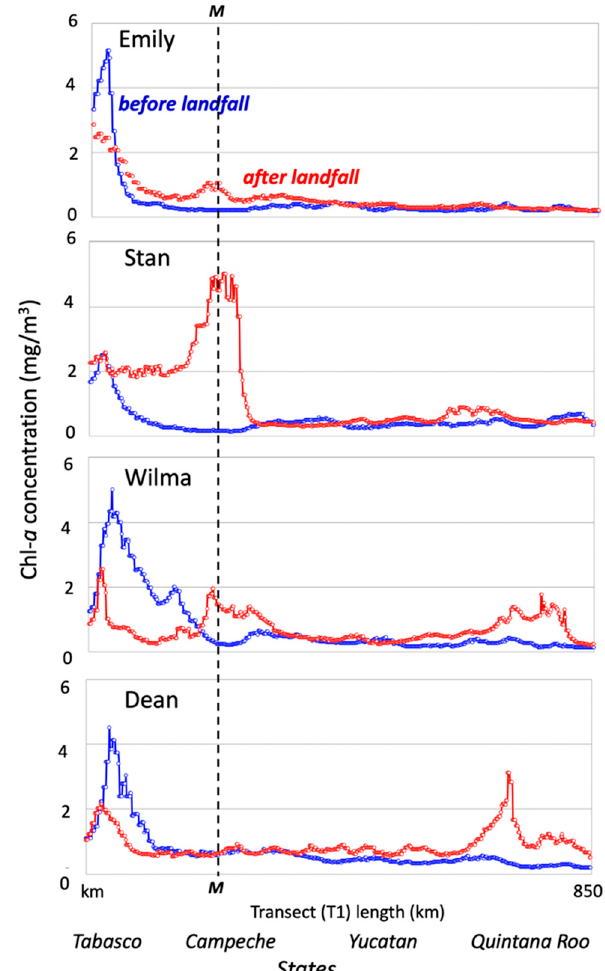
Figure 11. Chl -a (mg / m 3 ) average estimated along the marine profile (T1; water depth, 25 m) surrounding the coast of western Campeche and northern Yucatan and Quintana Roo (see Figure 10). Averages are from seven-day periods before (blue) and after (red) landfall; the dashed line indicates the location of site M in Figure 10A.